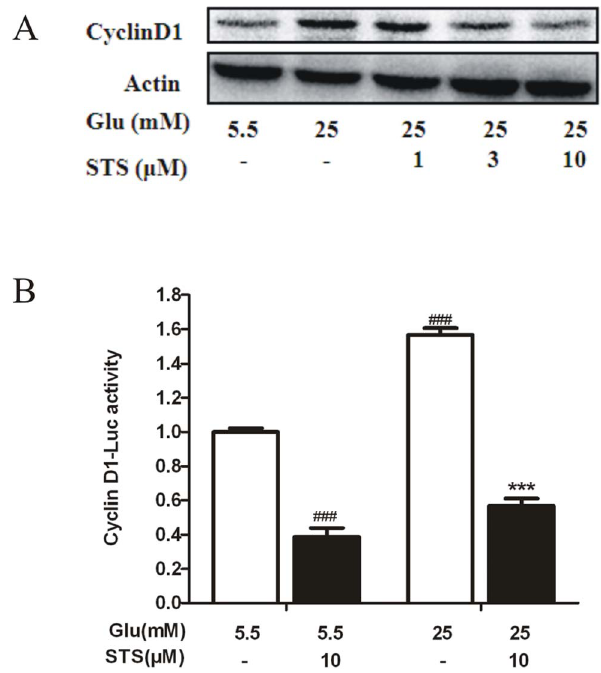
Figure 3. Effect of STS on HG-induced cyclin D1 expression. (A) VSMCs were treated with HG for 24 h in the presence of the indicated concentration of STS. Cyclin D1 expression was analyzed by Western blot, with b -actin as a loading control. Results are representative of three independent experiments. (B) STS decreases HG-induced cyclin D1 promoter activity. Cells were transiently transfected with pGL3- cyclin D1, and cultured with 25 mM glucose in the presence or absence of STS (10 m M) for 24 h. Luciferase activity was determined from cell lysates, as described in ‘‘Materials and methods.’’ Values are presented as means 6 SD. ### p , 0.001 vs control. *** p , 0.001 vs HG group.